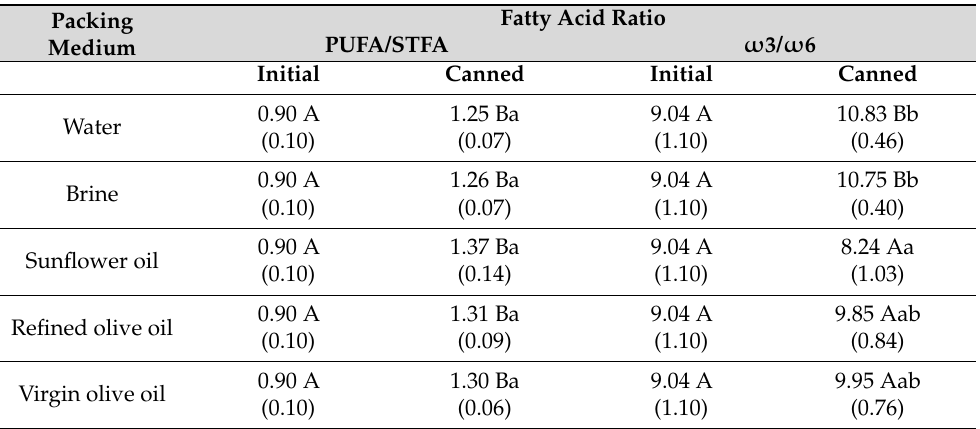
Table 1. Fatty acid ratios (PUFA/STFA and ω 3/ ω 6) in the lipid fraction of initial and canned mackerel